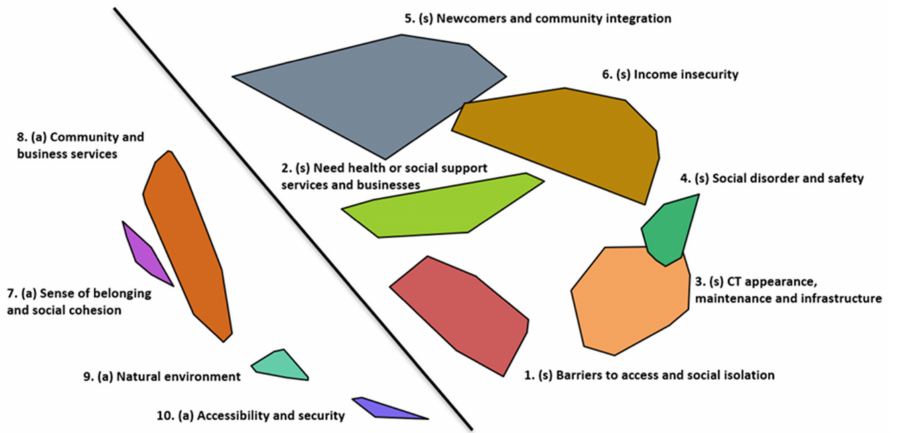
Figure 1. Cluster map of neighborhood chronic stressors (right) and assets (left) prior to stage of interpretation.